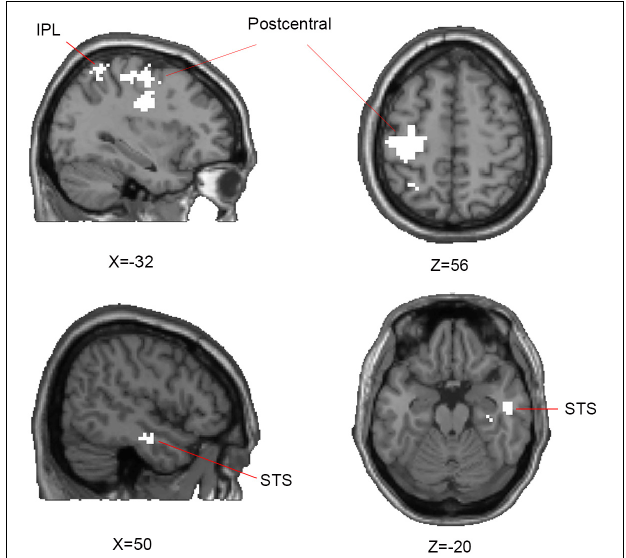
FIGURE 4 | Results of representational similarity analysis of whole-brain searchlight showing the significant clusters of abstract representation of emotion. For abstract representation of three emotions, three clusters are significantly correlated with the abstract emotion model: the left postcentral gyrus, inferior parietal lobe (IPL), and right superior temporal sulcus (STS) which are shown on axial and sagittal slices. One-side Wilcoxon sign-rank test was used in the second-level group analysis and p-map generated by thresholding at p < 0.01 with a minimum cluster-size of 30 contiguous voxels.